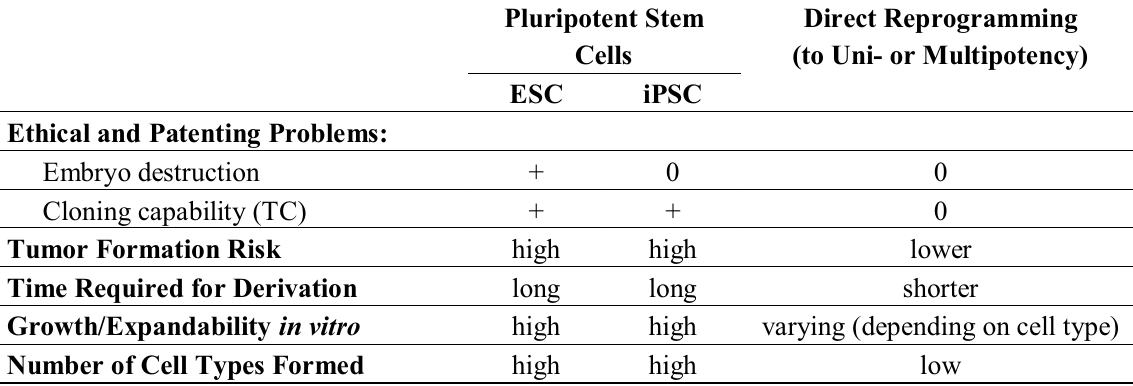
Table 2. Some Pros and Cons of Induction of Pluripotency vs. Direct